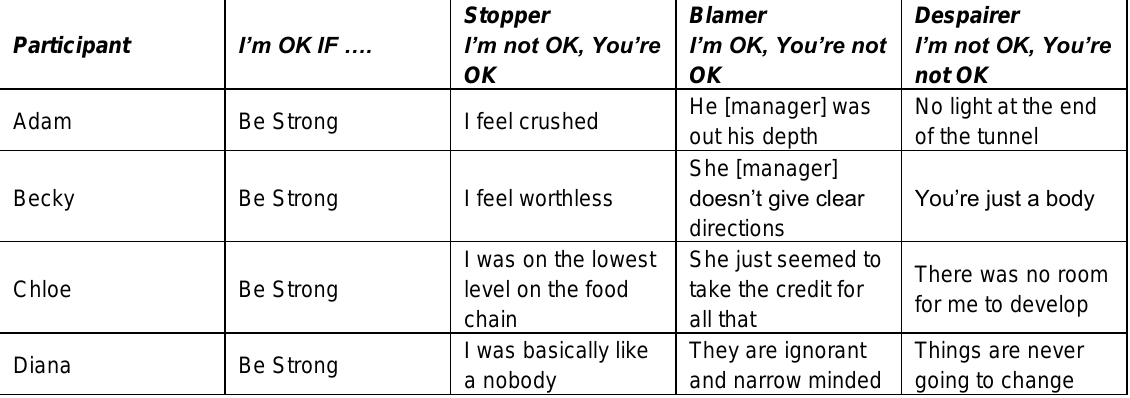
Table 4: Miniscript